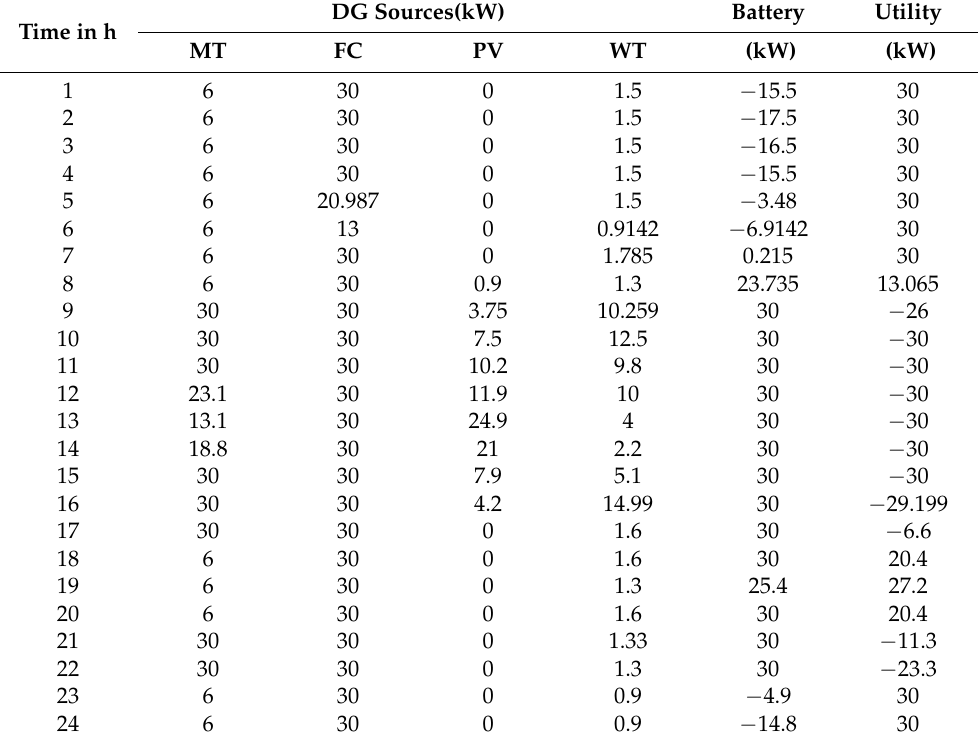
Table 3. Economic dispatch for Scenario 1.